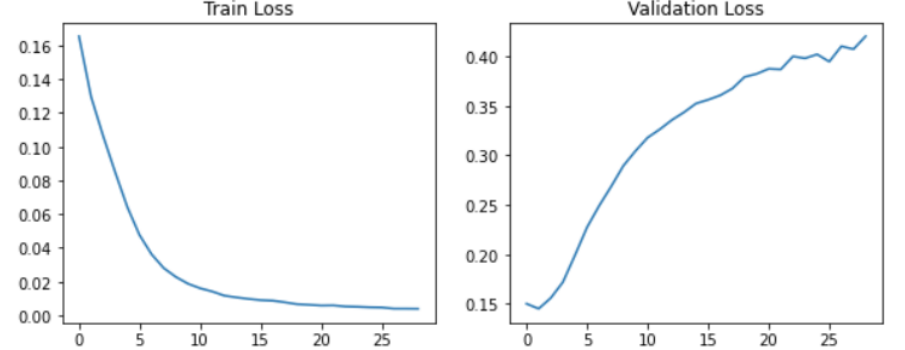
Figure 4. Overfitting behavior through losses in